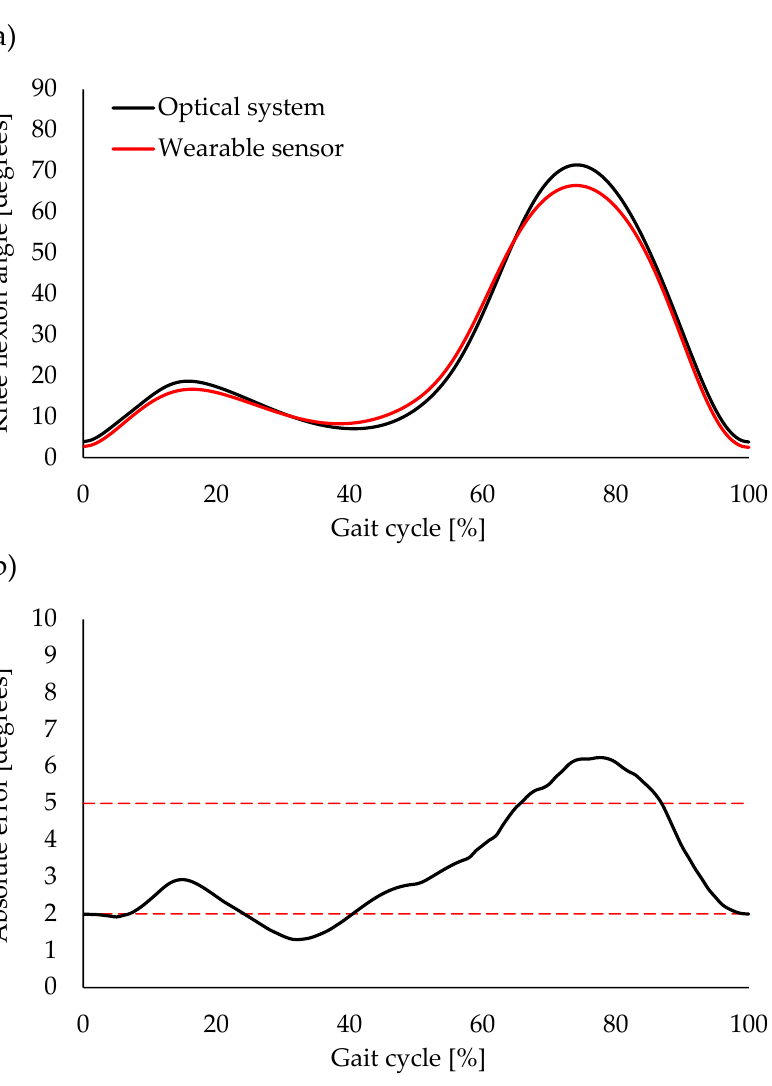
Figure 5. Average waveforms of knee flexion angle during a gait cycle for optical motion analysis and wearable goniometer ( a ), and absolute error (AE) between the optical motion analysis and wearable goniometer ( b ). Broken red lines indicate thresholds of interpretation for AE (AE ≤ 2 ◦ was good accuracy, 2 < AE ≤ 5 ◦ was acceptable accuracy, and 5 ◦ < AE ≤ 10 ◦ was tolerable